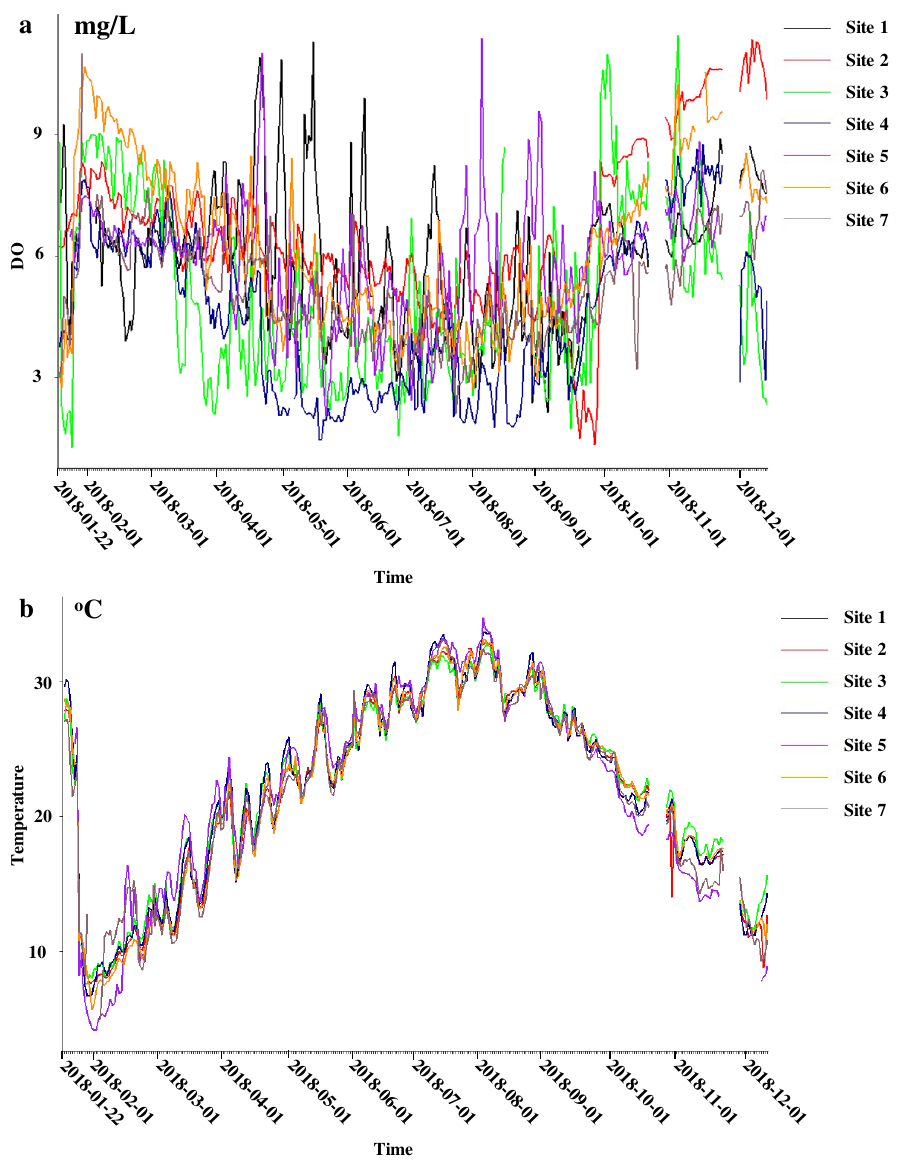
Figure 2. Time series of ( a ) DO and ( b ) water temperature at seven on-line monitoring stations during one- year period.